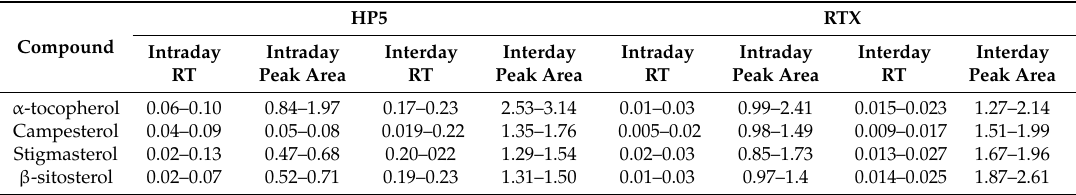
Table 2. Intraday and interday repeatability (expressed as % RSDs) of the area and retention time of the compounds in the HP-5ms and RTX-200MS